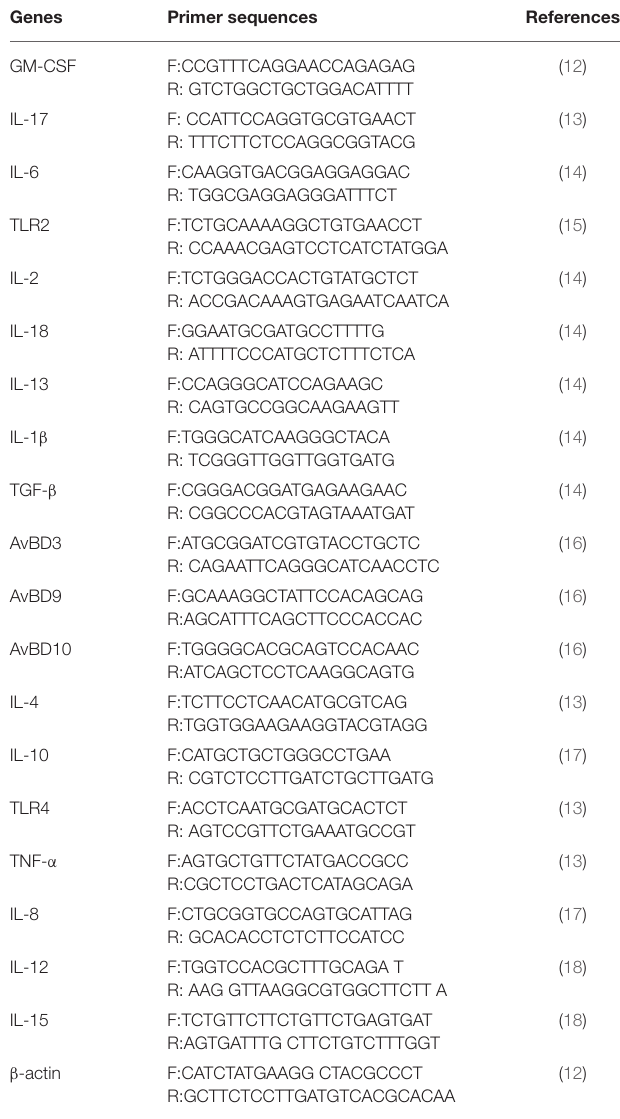
TABLE 1 | Primers used for